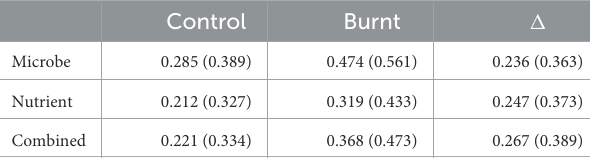
TABLE 3 R 2 adj ( R 2 in parentheses) for RDA analysis on dependent variable categories (left column) for the 3 variable sets (header